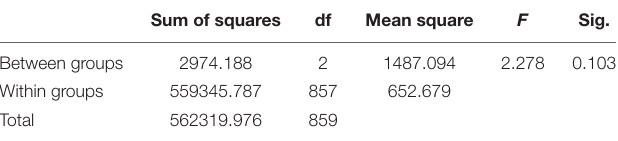
TABLE 10 | The results of ANOVA for English level. Sum of squares df Mean square F